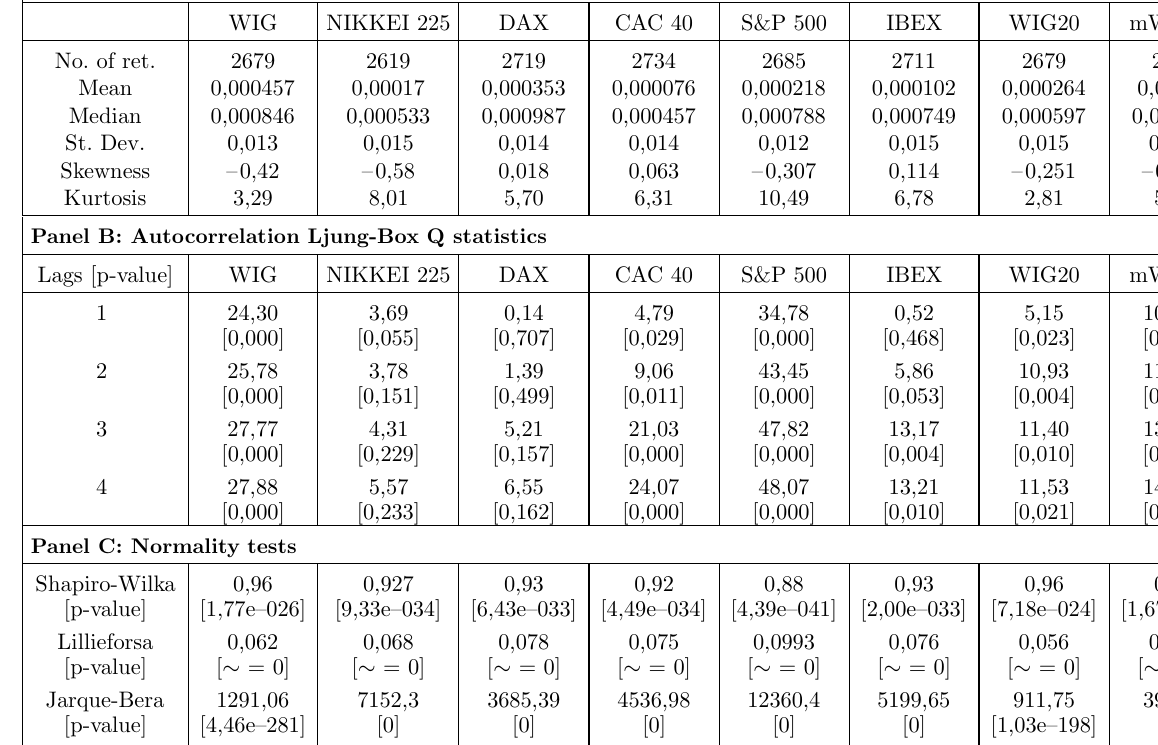
Descriptive statistics of the returns time series from the period: January 2003 – September 2013 Panel A: Descriptive